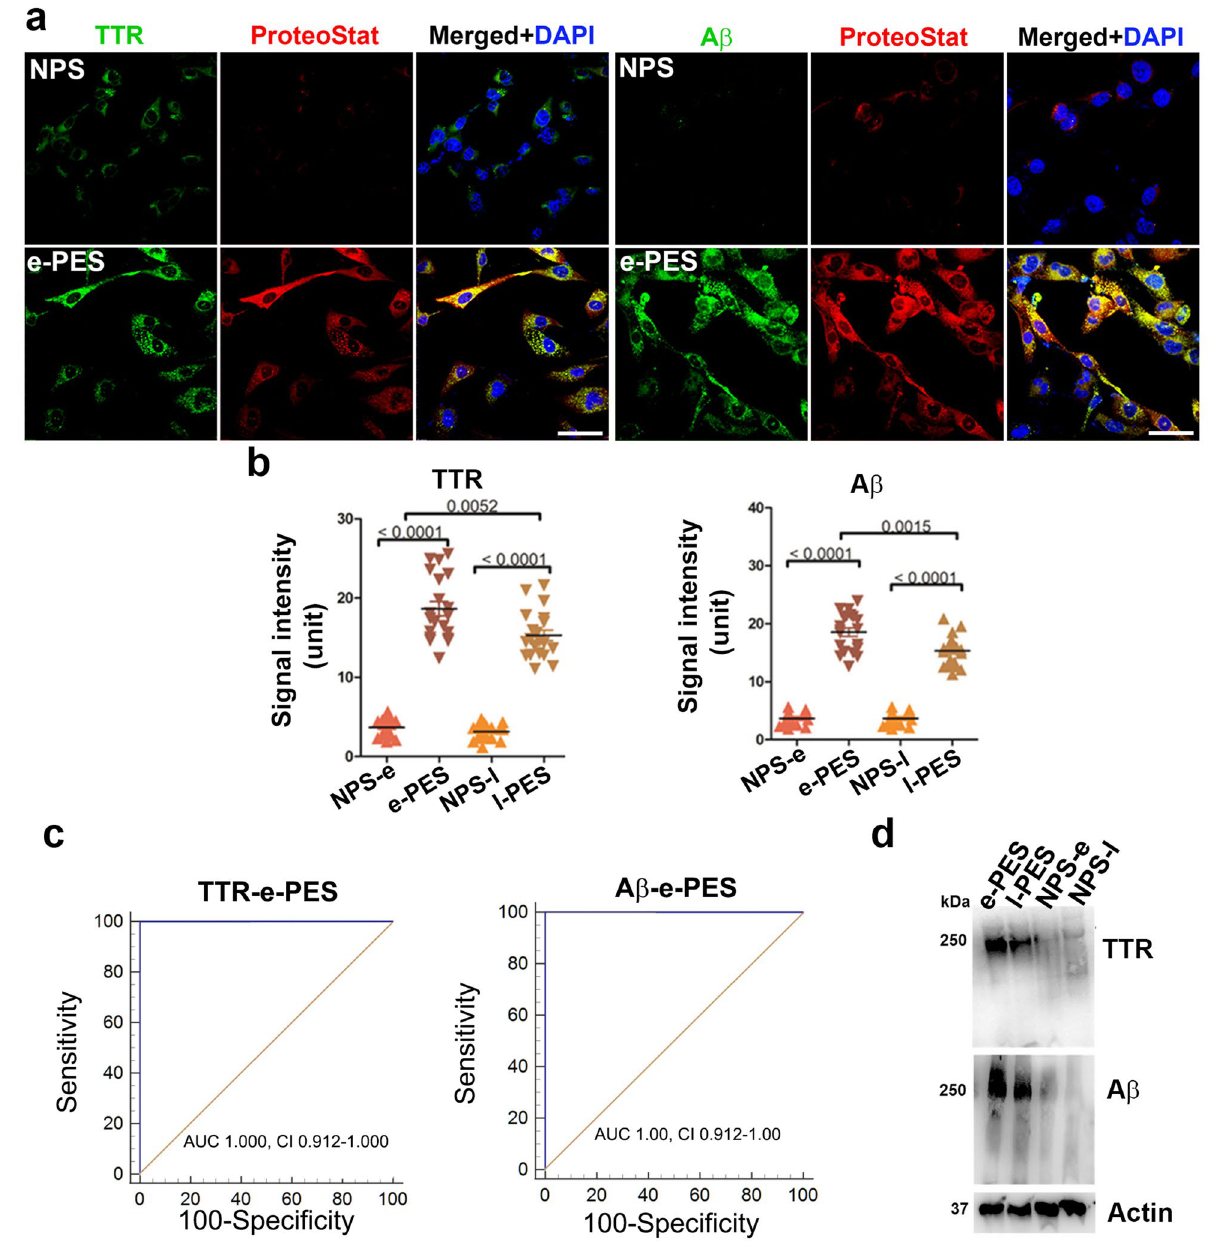
Figure 3. Identification of protein components of the aggregates in PE serum using co-localization staining with specific antibodies and ProteoStat dye and immunoblotting. ADTs were incubated with sera from e-PE (e-PES) or normal pregnancy controls and fixed at 24 h. ( a ) Fixed cells were serially stained with anti-TTR (green) or anti-Aβ antibodies (green) and ProteoStat dye (red). The nuclei were stained with DAPI (blue). Bar: 50 µm. ( b ) Quantitative analysis of signal intensity of TTR and Aβ in NPS- and e-PES/l-PES-treated cells. ( c ) ROC curve analysis of TTR and Aβ aggregates in sera from patients with e-PE and l-PE. Dual immunostaining for TTR and Aβ in combination with ProteoStat staining was performed in ADTs incubated with e-PE sera (e-PES), l-PE sera (l-PES) or respective control sera. The intensity of TTR and Aβ immunoreactive signals that were co-localized with ProteoStat fluorescence was measured and plotted for ROC curve. ( d ) Protein extracts were separated using western blotting under native conditions. The blots were then probed for TTR and Aβ. Actin was used as a loading control. Experiments were repeated at least 3